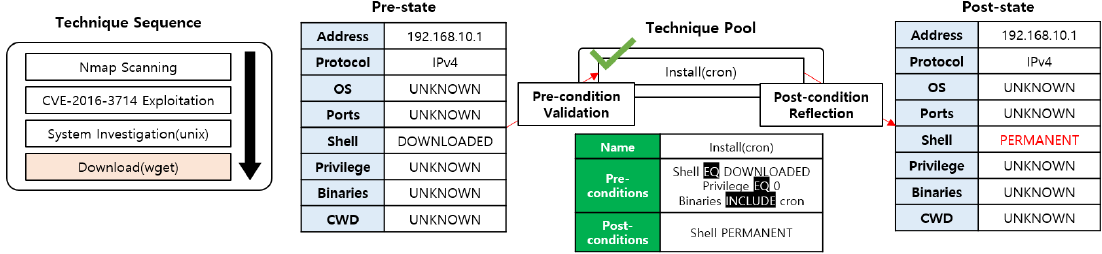
Figure 6. The example of the process of scenario generation: RAT installation chosen.